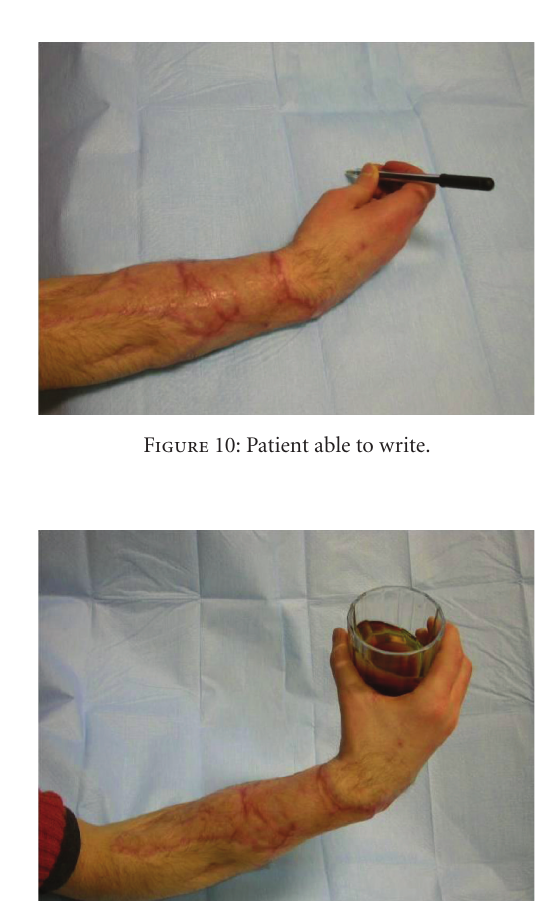
Figure 11: Patient able to carry a glass.